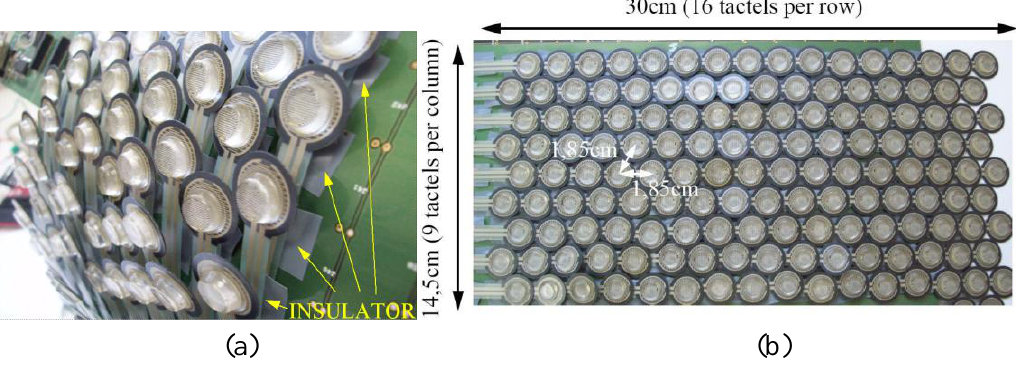
Figure 7. ( a ) Detail of the placement of the sensors, and ( b ) a photograph of the whole array.